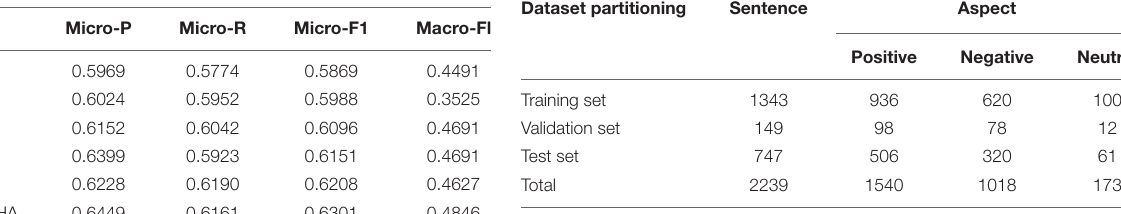
TABLE 3 | Comparison between the experimental results of models based on the TikTok dataset.